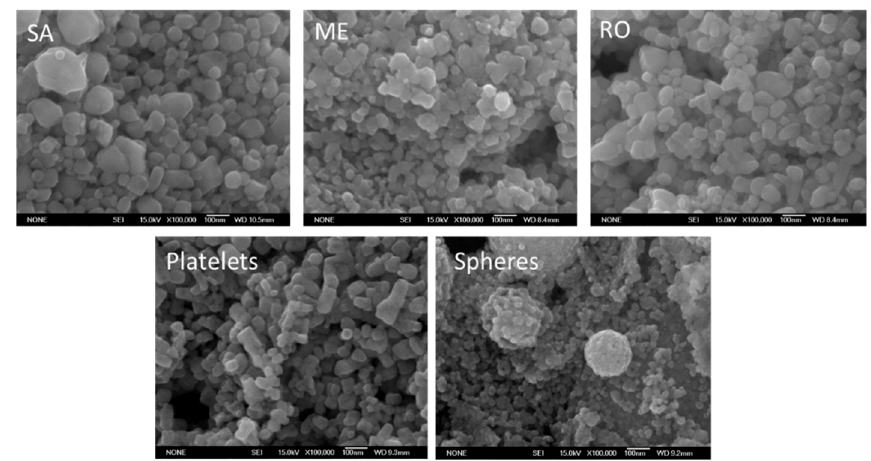
Figure 1. SEM pictures of the sensitive WO 3 layer.